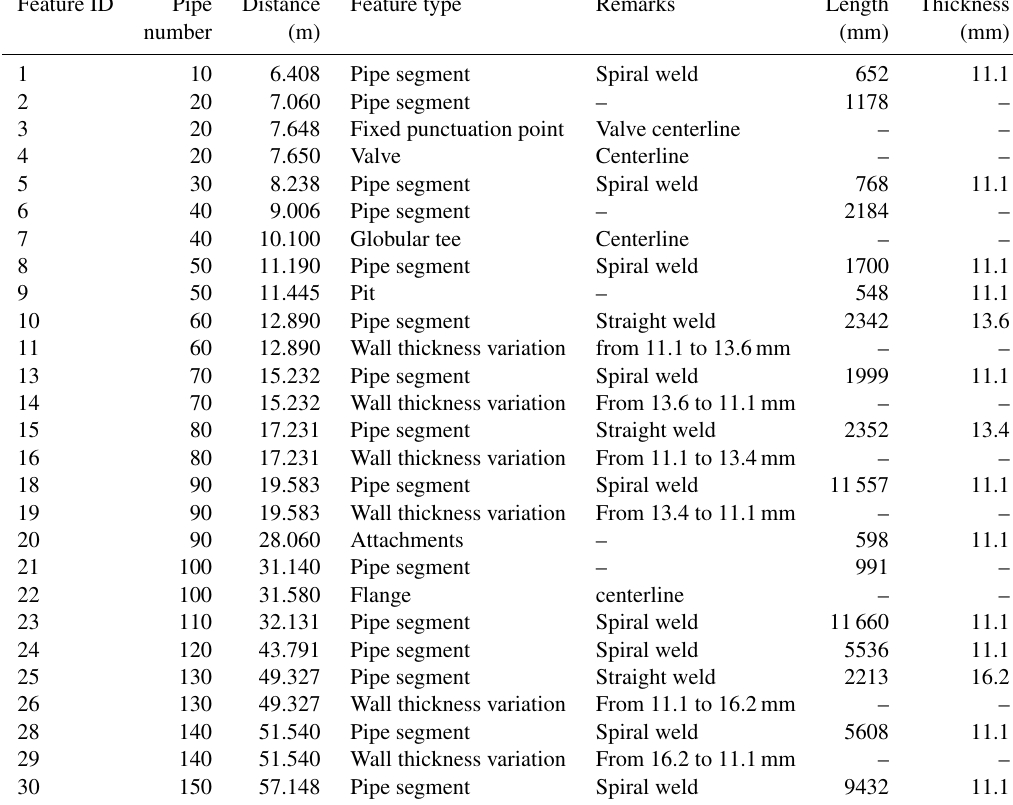
Table E1. Internal detection data of each pipeline. Feature